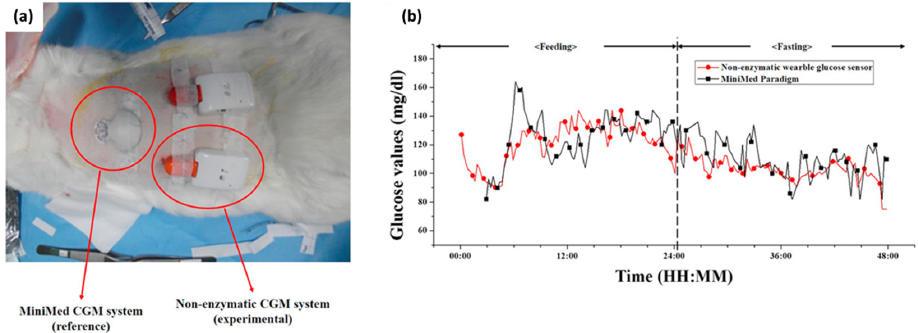
Figure 5. In vivo investigation of the developed non-enzymatic continuous glucose monitoring system. ( a ) Photograph of the developed non-enzymatic continuous glucose monitoring (CGM) and MiniMed CGM as a reference, which were implanted on a rabbit. ( b ) ISF glucose values measured using the MiniMed CGM (black line with square) and the developed non-enzymatic CGM (red line with circle) in animal experiment